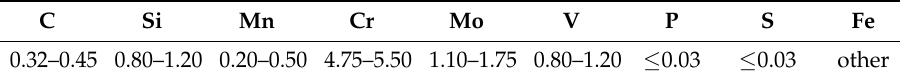
Table 1. Chemical composition of H13 hot work mould steel/wt